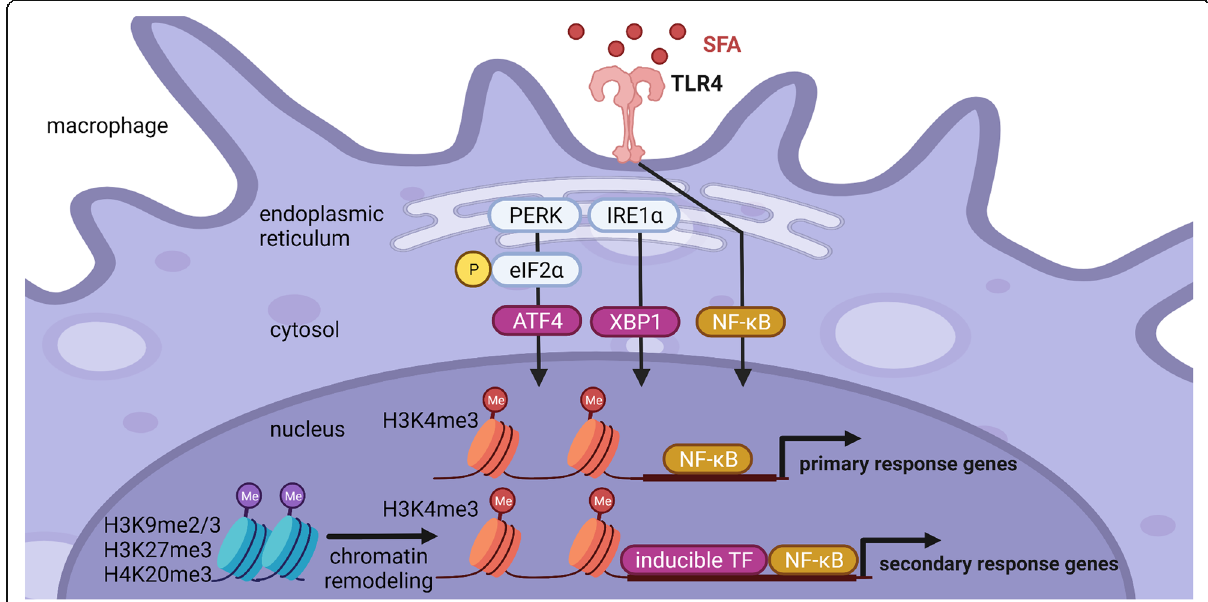
Fig. 1 Potential mechanism of metabolic and epigenetic regulation of TLR4 signaling. ER is an interface between immune and metabolic systems. PERK and IRE1 α , along with their downstream effectors, ATF4 and XBP1, respectively, are involved in SFA-induced metabolic inflammatory responses. TLR4 signal – mediated proinflammatory cytokines are divided into the following two groups. Primary response genes are rapidly upregulated in response to stimuli, while secondary response genes are induced later. Accumulating evidence has highlighted the significant role of chromatin remodeling in the regulation of these upon TLR4 activation. Among others, covalent modifications at histones H3 and H4 have been shown to play a key role in regulating chromatin assembly and the recruitment of inducible transcription factors, suggesting the epigenetic regulation of TLR4 signaling. Created with